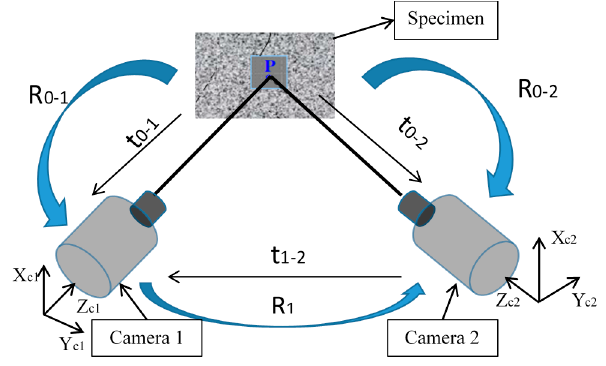
Figure 4. Calibration parameters in stereoscopic DIC system.